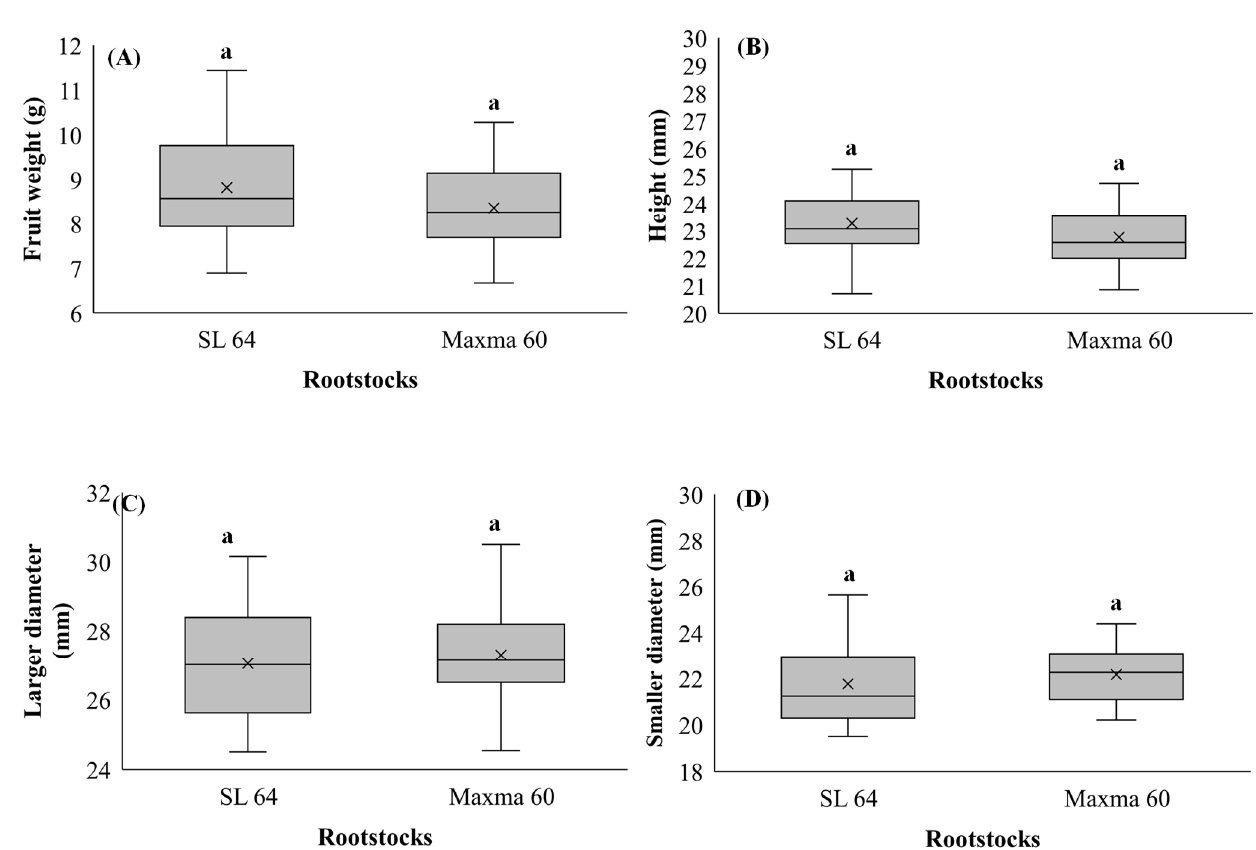
Figure 2. ( A ) Weight, ( B ) height, ( C ) larger diameter and ( D ) smaller diameter of sweet cherry cv. Early Bigi grafted on SL 64 and Maxma 60 rootstocks. Different letters indicate statistically significant differences ( p < 0.05) according to Duncan´s test.